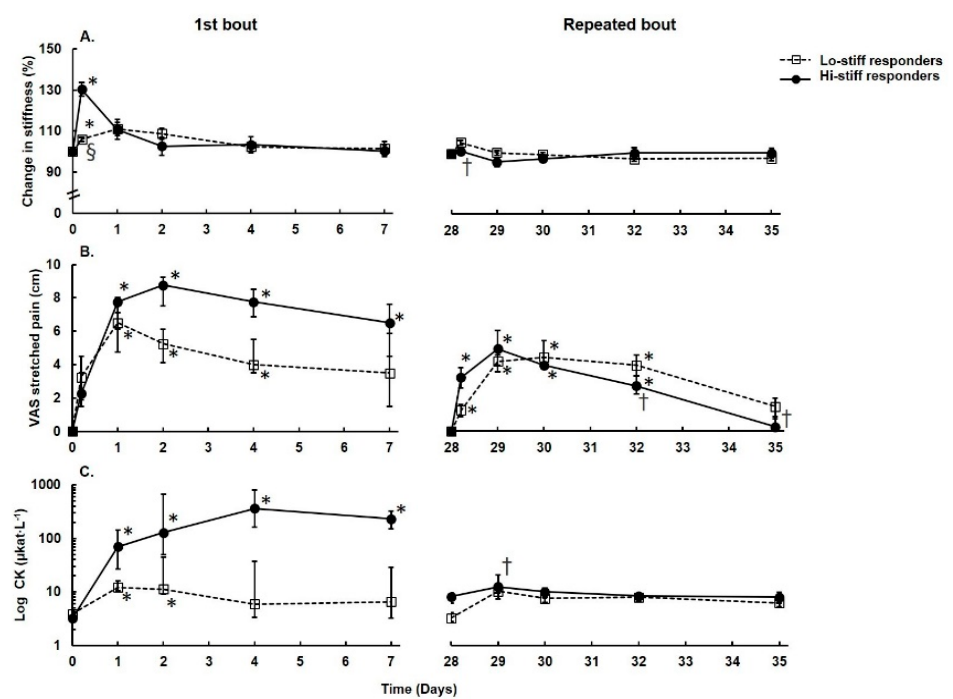
Figure 3. Variable responses to the repeated bout identified as the change in passive MTU stiffness. Filled circles and solid lines are the data for the highest stiffness response (“high responders,” n = 4); open circles and dashed lines are the data for the lowest stiffness response (“low responders,” n = 4). ( A ) Change in passive MTU stiffness. ( B ) Visual analog scale score for the pain of stretched muscle. ( C ) Plasma creatine kinase (CK) activity on a log scale. Data are presented as the median and interquartile range (IQR) except for stiffness data, which are presented as the mean and standard error of the mean. * Significant difference from the pre-exercise value ( p < 0.05). † Significant difference from the first exercise bout ( p < 0.05). § Significant difference between high and low responders ( p < 0.05).